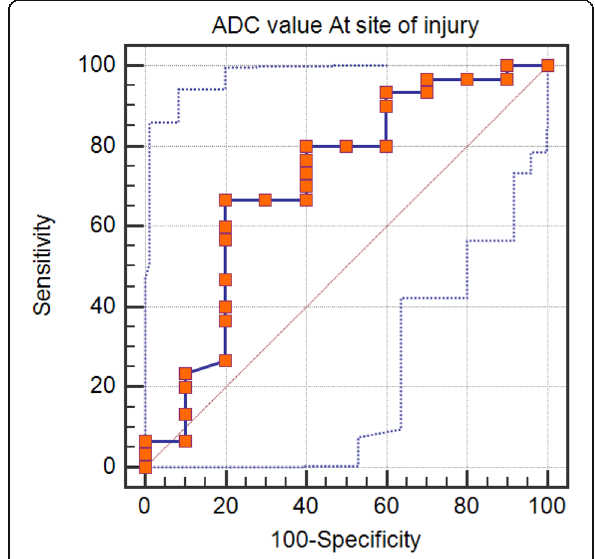
Fig. 7 ROC curve between patients and control groups according to ADC